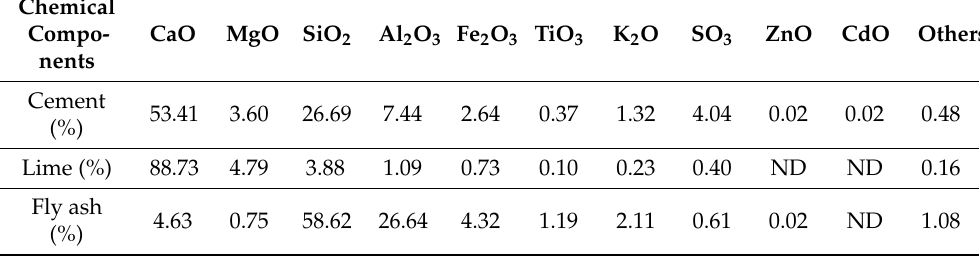
Table 3. Chemical components of the three